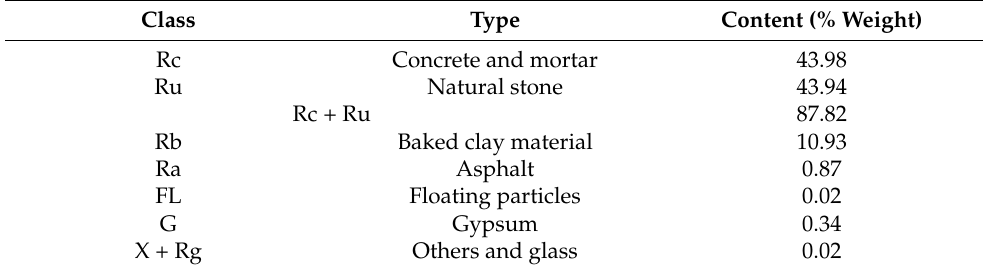
Table 3. Components of the mixed recycled gravel (cMRA) (EN 933-11 classification [37]).